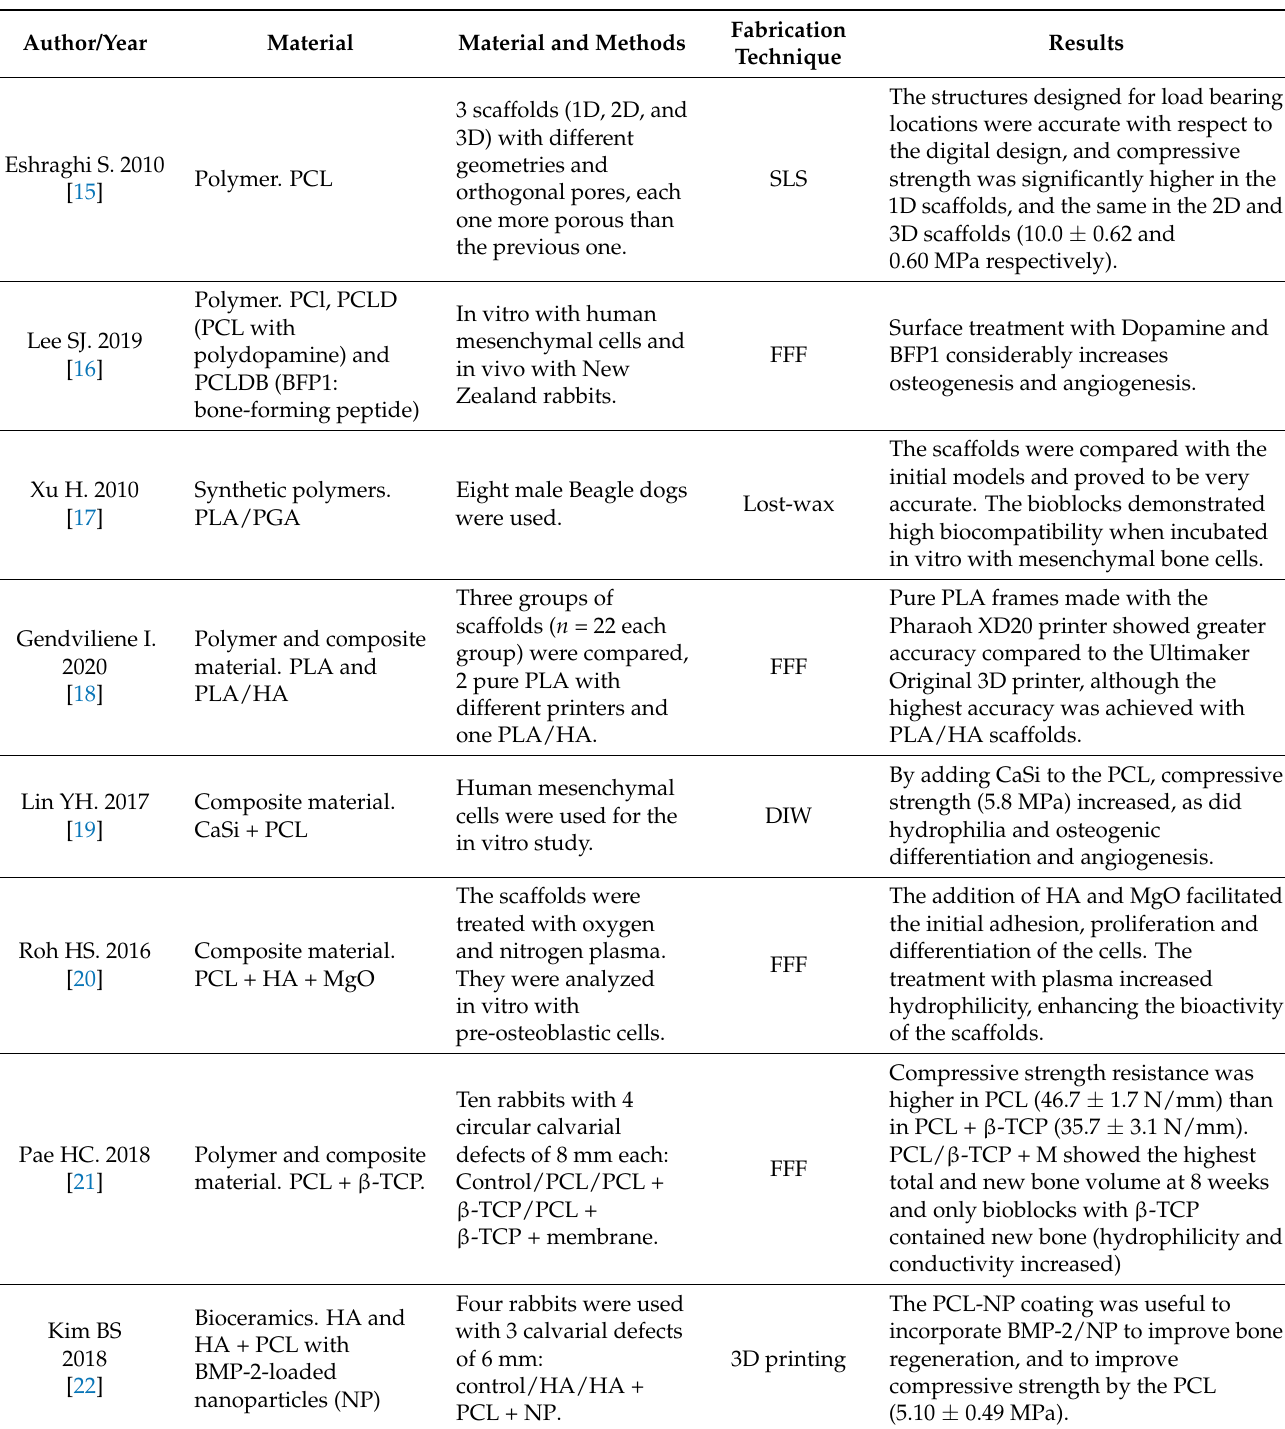
Table 1. Description of the 16 studies that, both in vivo and in vitro, evaluate the mechanical and regenerative properties of the different materials used to manufacture 3D scaffolds